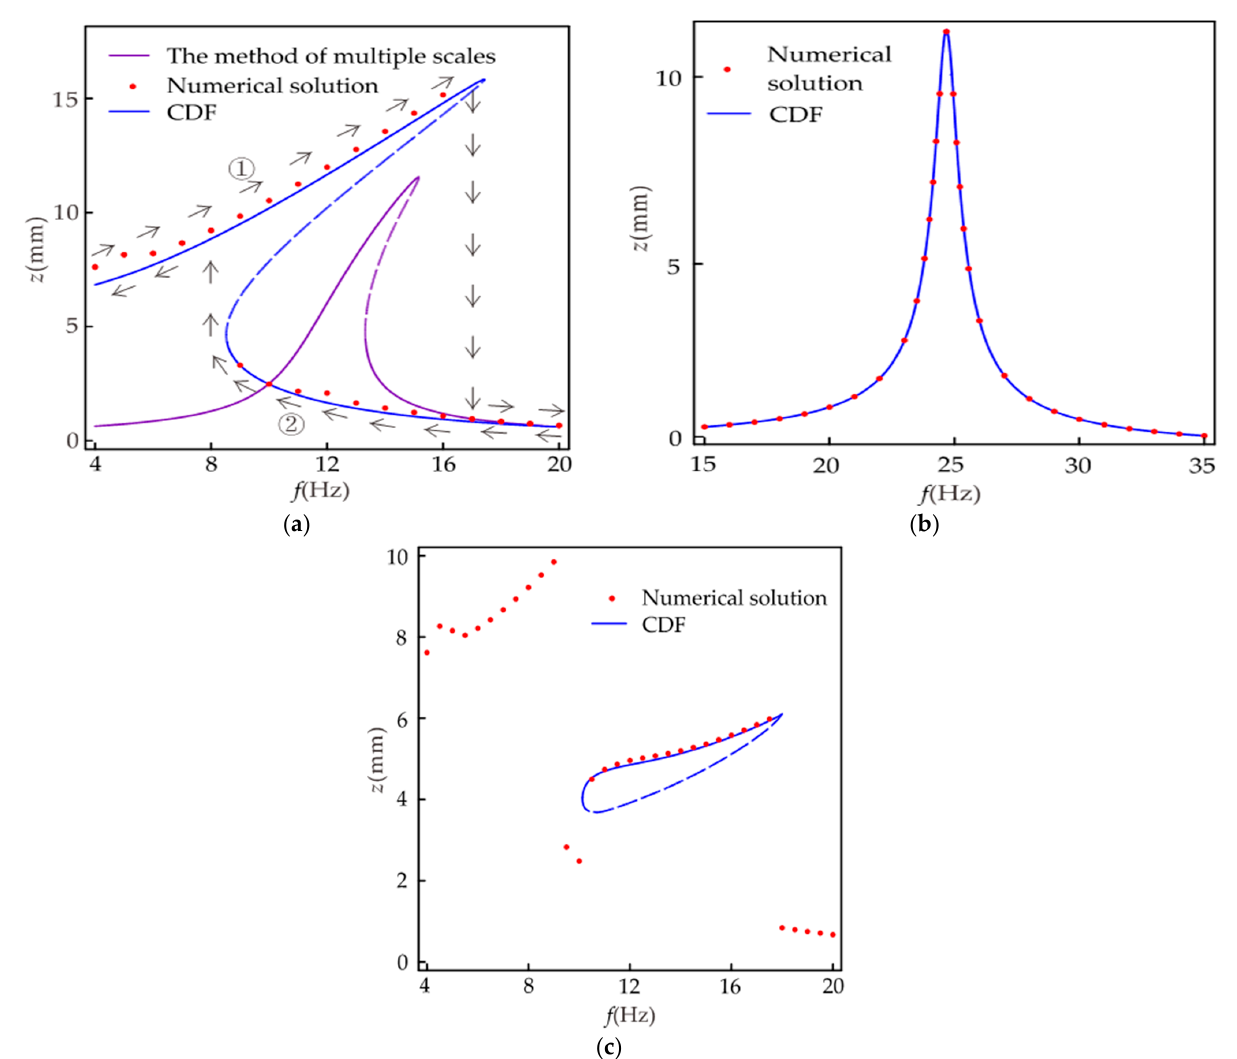
Figure 8. Displacement versus frequency with p = 9 m/s 2 , d = 24 mm: ( a ) nonlinear system (primary resonance); ( b ) linear system (primary resonance); ( c ) nonlinear system (1/3 subharmonic resonance).